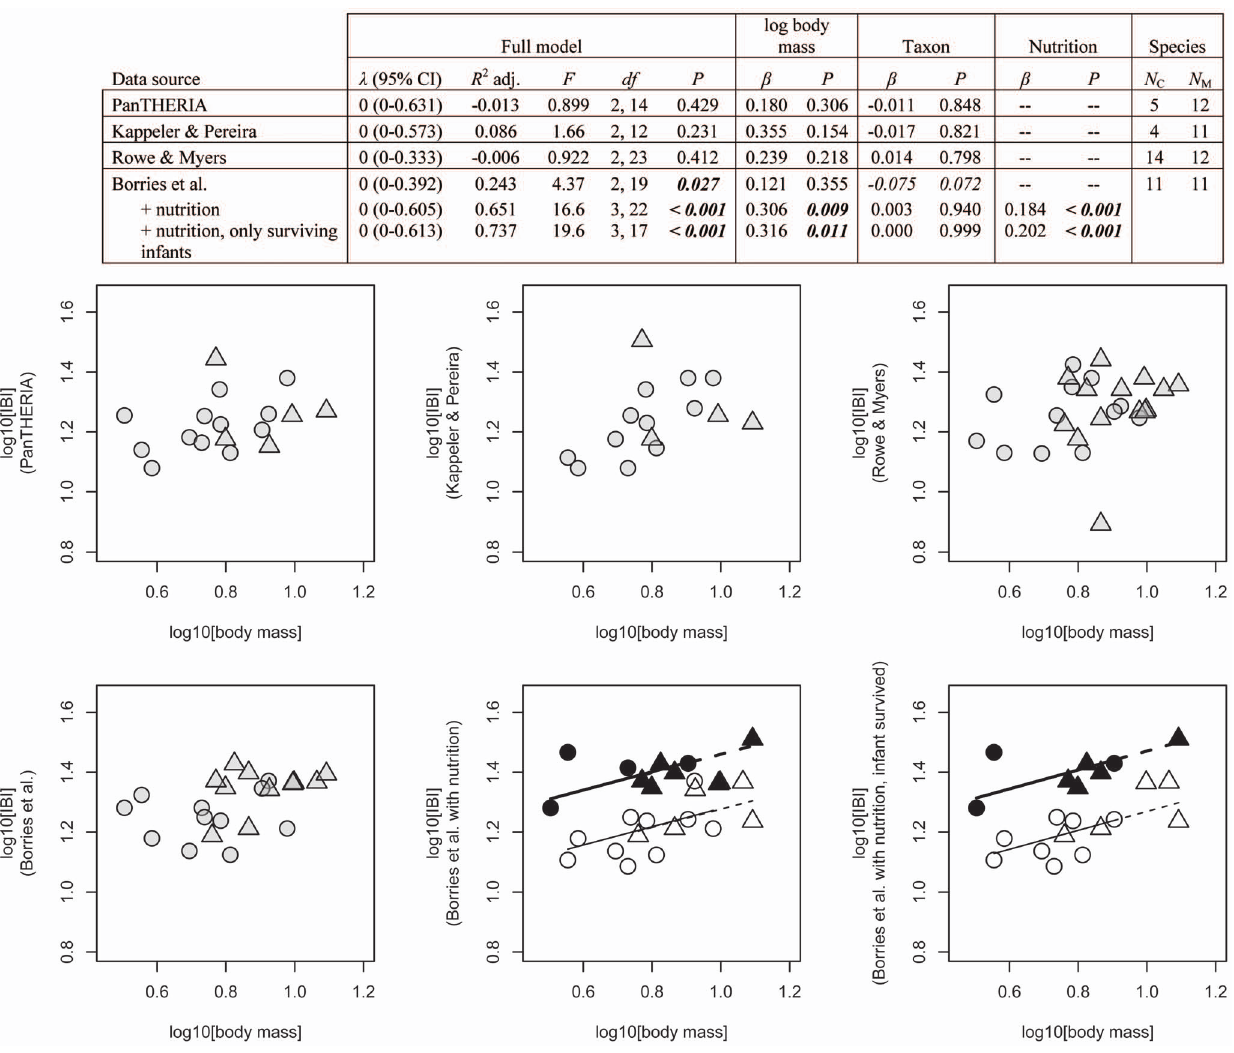
Figure 4. Interbirth interval, IBI [log10 months] in relation to adult female body mass [log10 kg] for different databases. Symbols and abbreviations as in Fig. 2. Note that dotted lines fall on top of the solid lines in the last two plots; i.e., the scaling relationships are very similar for Asian colobines and Asian macaques.